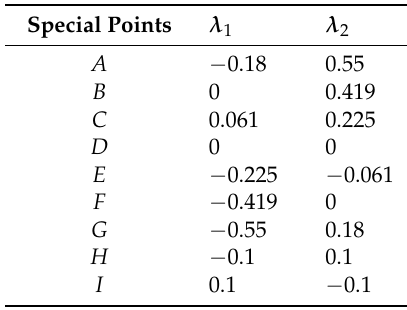
Table 1. Section parameter corresponding to nine special